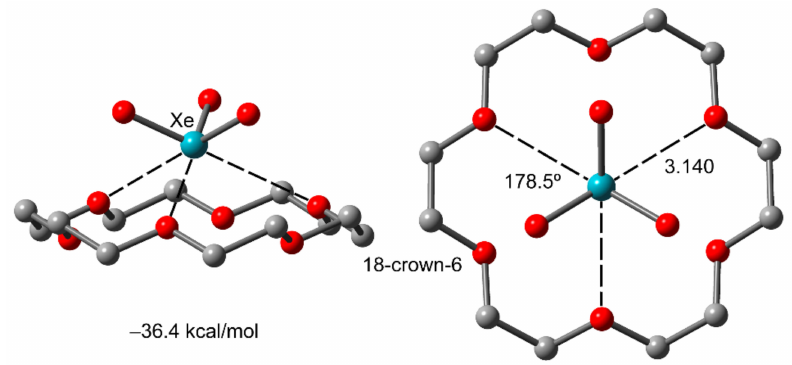
Figure 8. Perspective and on-top views of the complex of XeO 3 with 18-crown-6 and its interaction energy. Distances in Å.